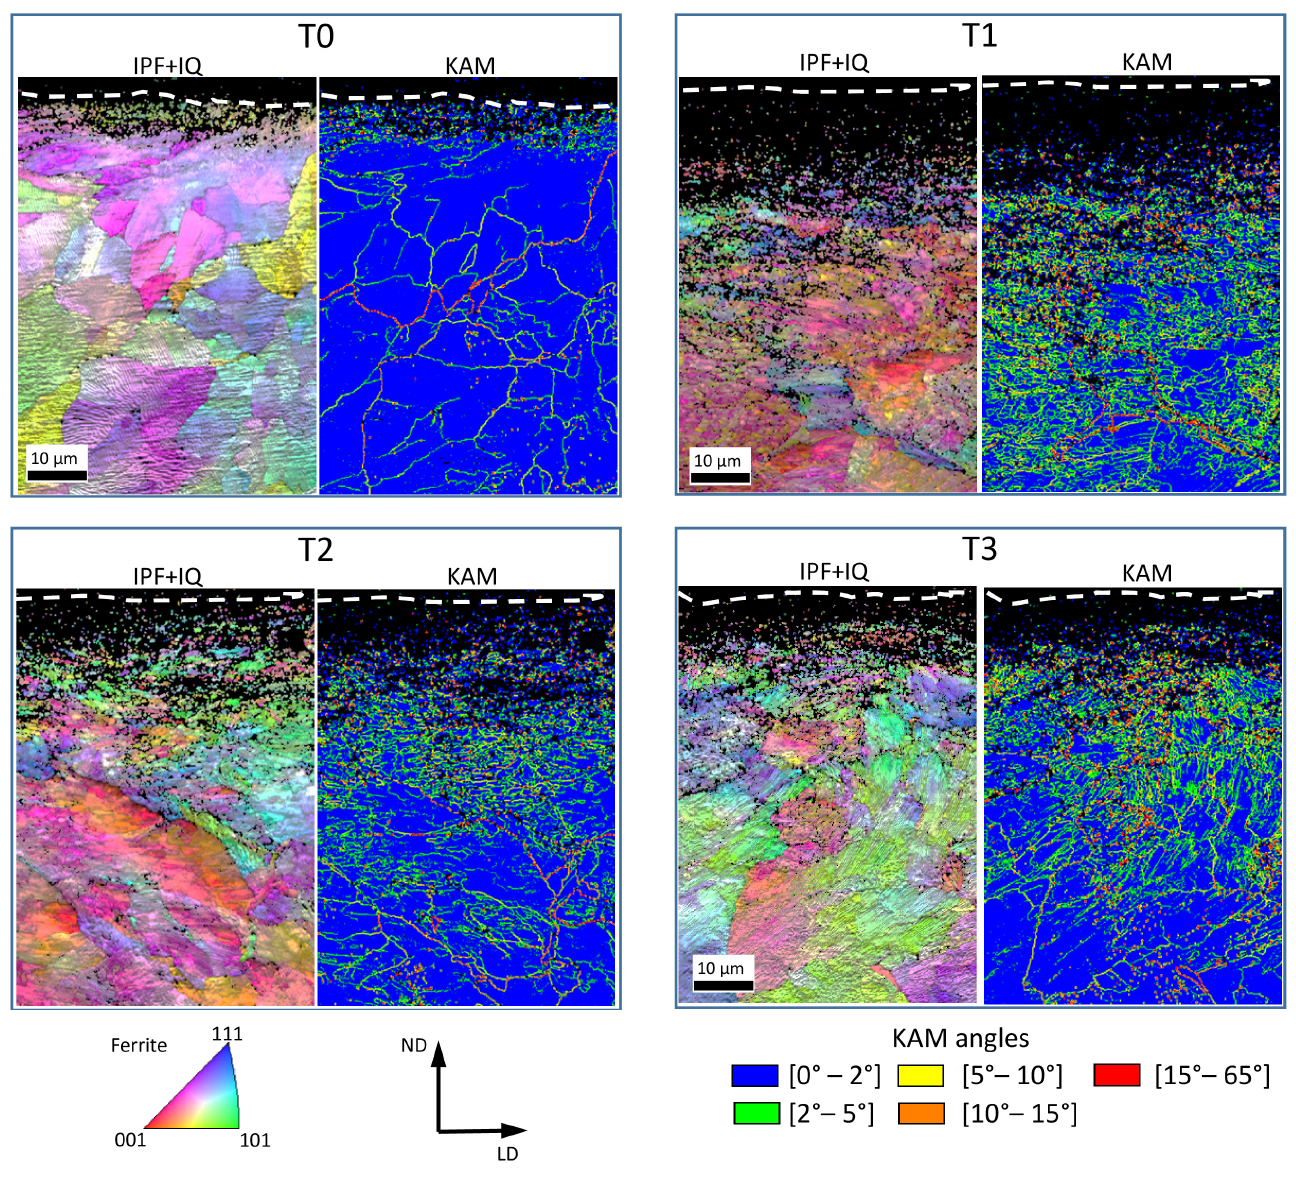
Figure A3. IPF map with IQ and KAM maps for the non-deformed state (T0) and the different testing conditions (T1, T2, T3), for Ring AT. The measurements were performed along the longitudinal direction.